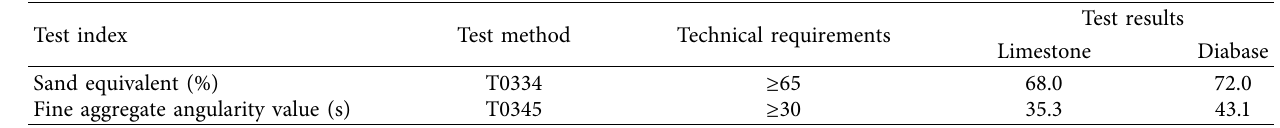
Table 6 and Figure 4 present the following results: